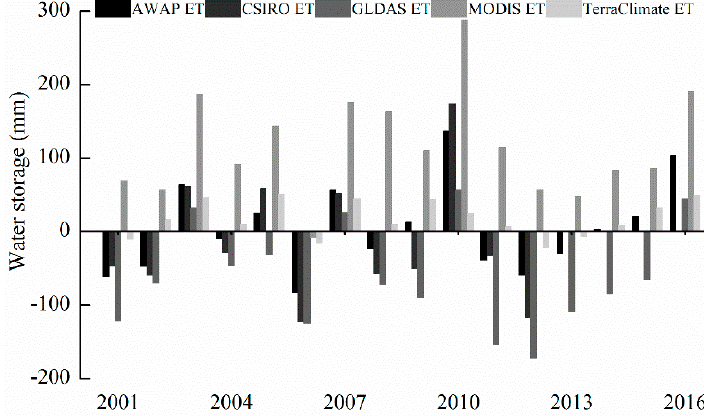
Figure 6. The yearly water storage changes estimated using different ET products.